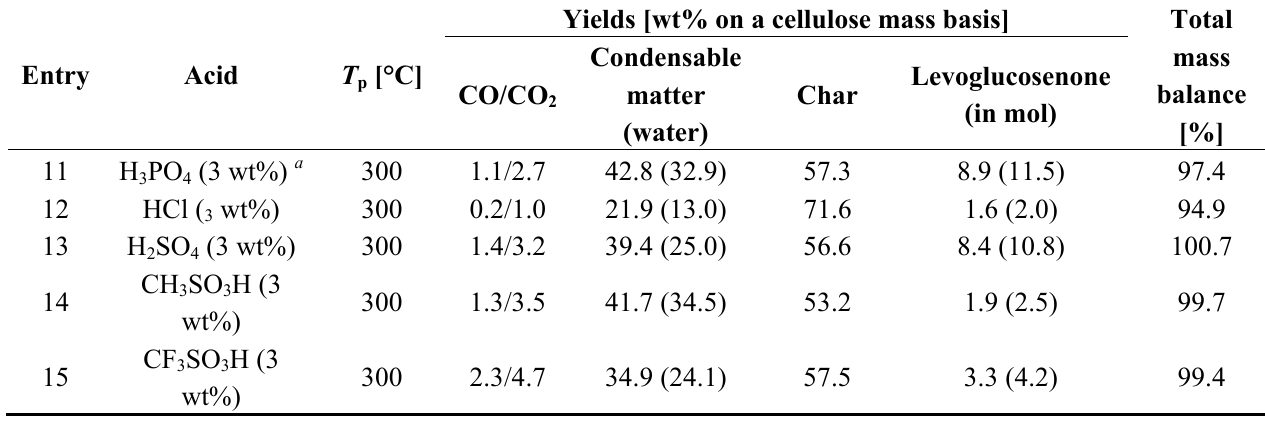
Table 3. Yields of products from pyrolysis of cellulose impregnated with organic or inorganic